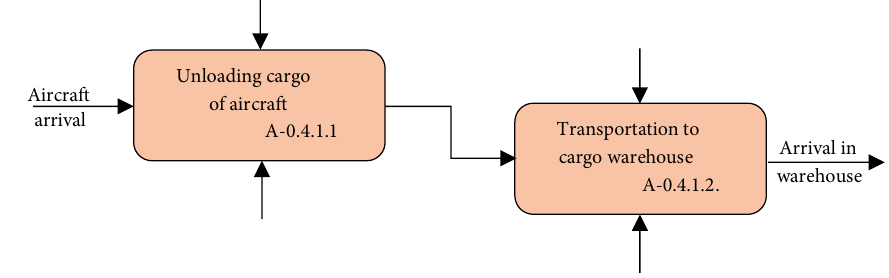
Figure 3: Further decomposition—air cargo handling subprocess